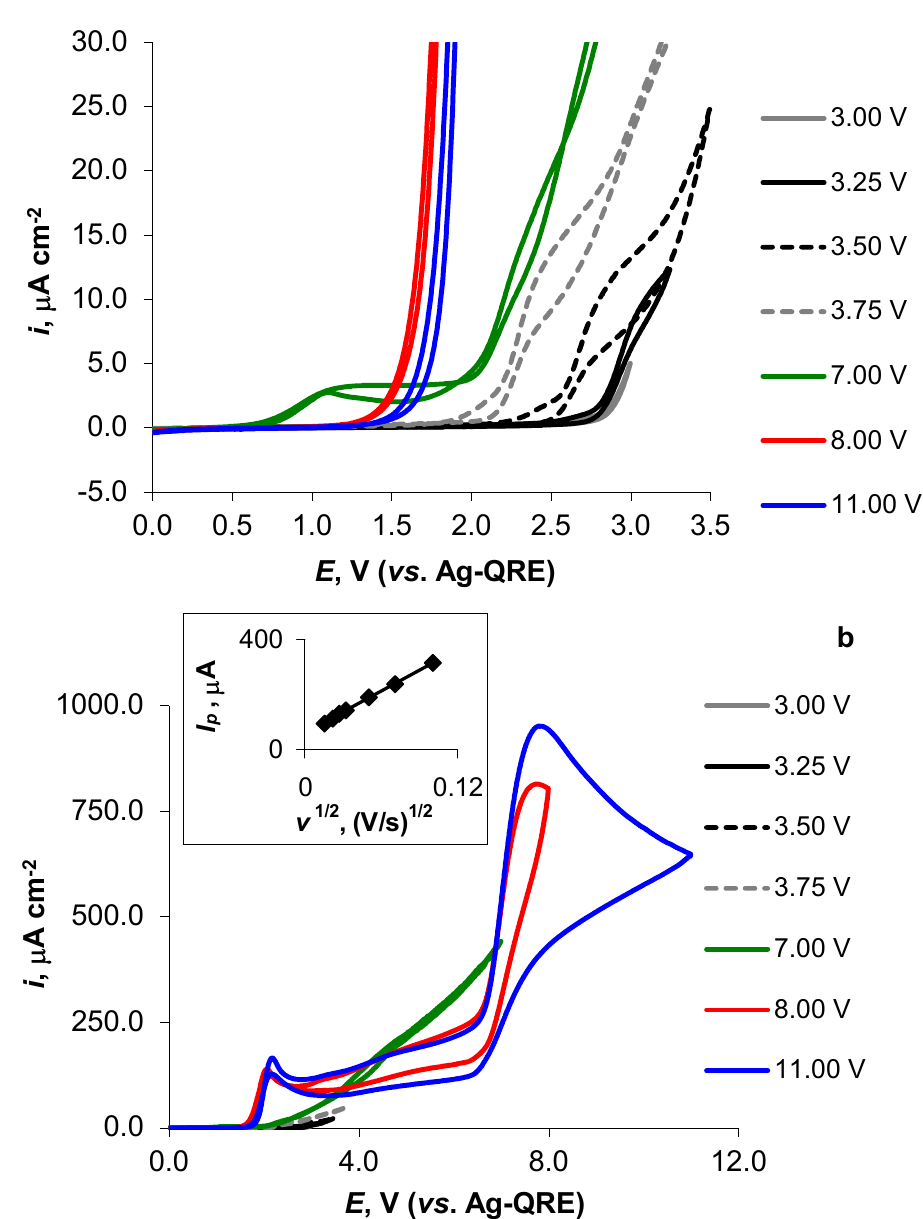
Figure 3. The cyclic voltammograms (CV), shown in different i and E scales, measured within the potential range from 0.00 V to the final potentials (indicated in the figure) and reverse at the potential sweep rate of 1.00 mV s − 1 ( a , b ). The second CV sweeps are presented; the potential sweep directions are indicated in the figures with arrows. I p vs. v 1/2 relationship, for the electro-oxidation process at E = 7.8 V, is shown in ( b ).